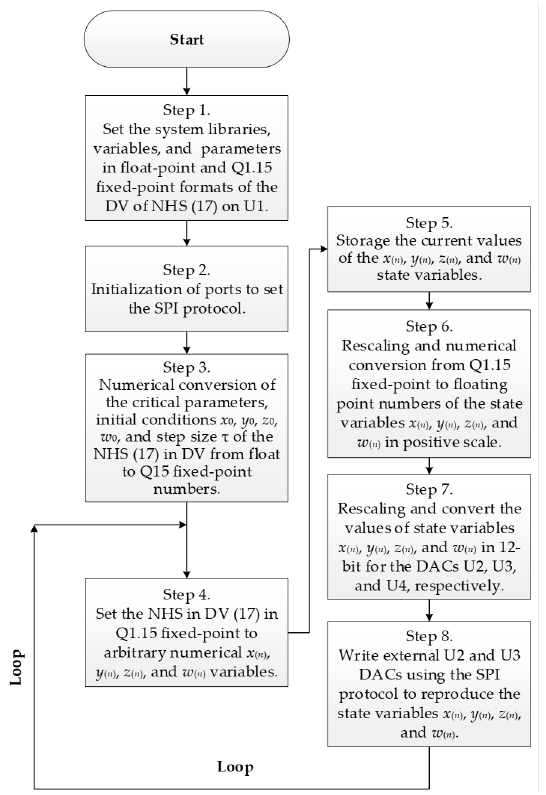
Figure 11. Flow chart of the electronic/digital implementation process in Q1.15 fixed-point version of NHS